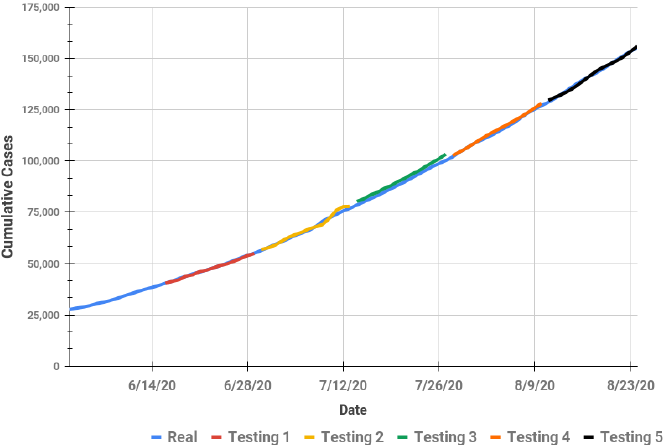
Figure 5. Actual and long-term forecasting for cumulative COVID-19 cases using the FPA model.